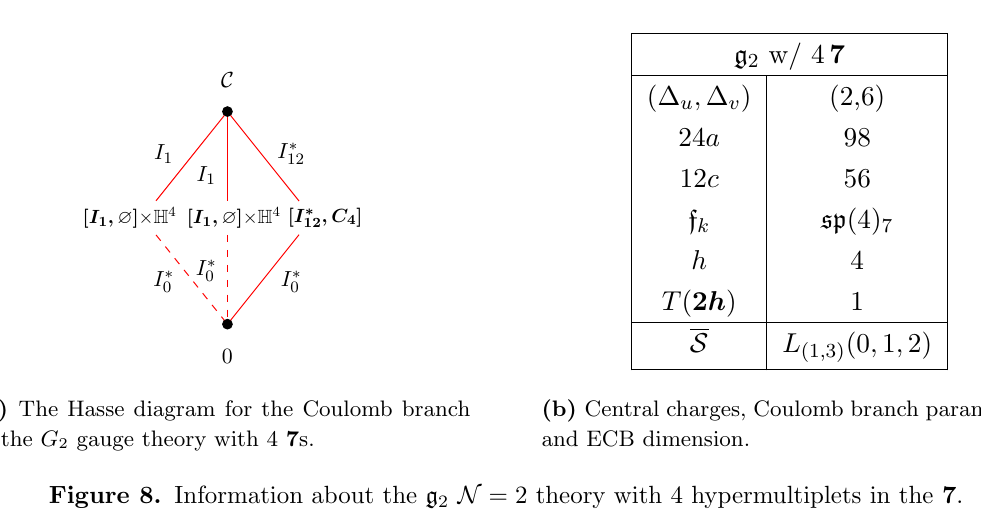
Figure 8. Information about the g 2 N = 2 theory with 4 hypermultiplets in the 7